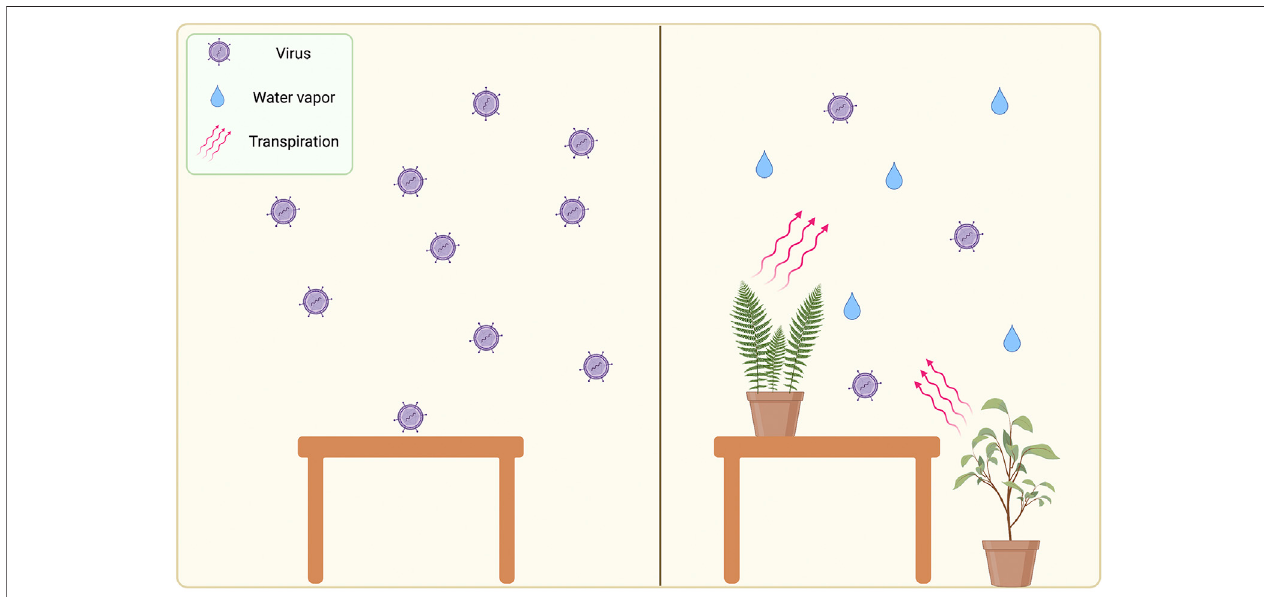
FIGURE3| illustrationofthepotentialroleofindoorplantinreducingairbornevirusesviaregulationofhumidity.Leftsectionrepresentaplant-freeenvironmentwith low relative humidity and high viral transmission. Right section represents effect of plants on increasing the humidity and reducing the viral transmission. This fi gure is created by BioRender